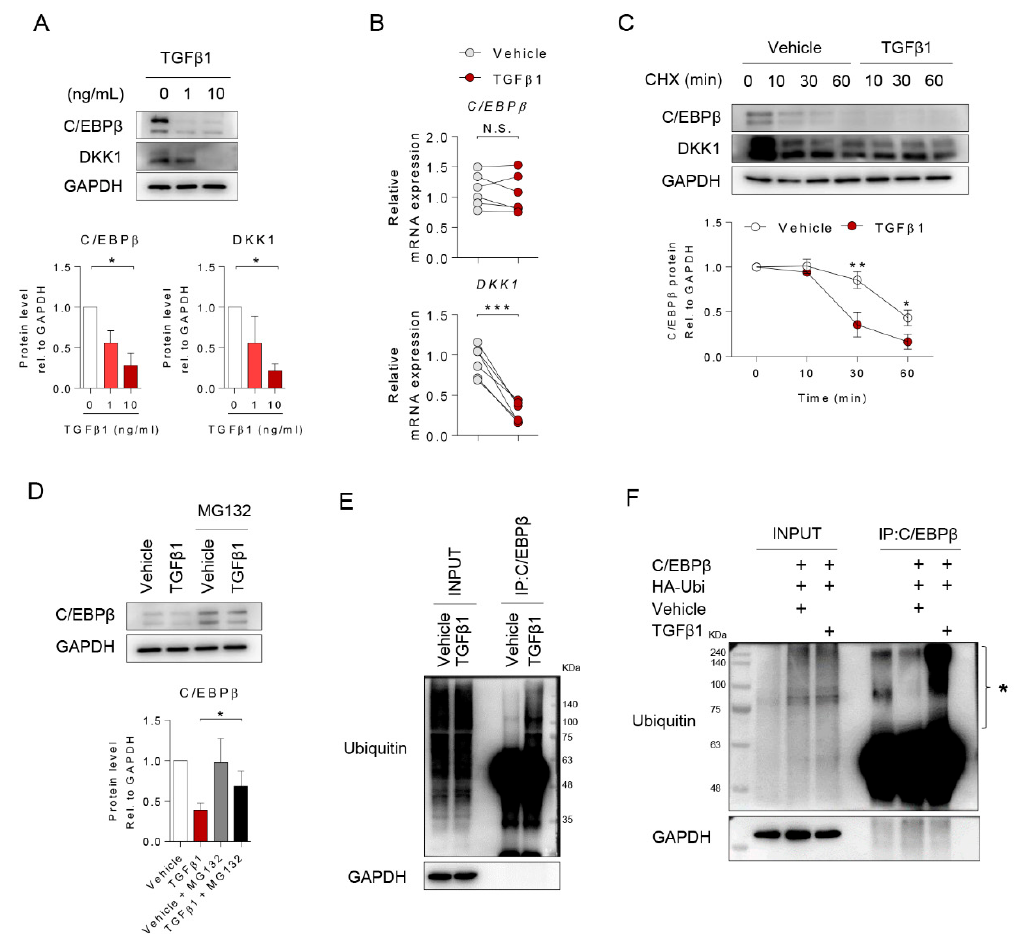
Figure 4. TGF β 1 inhibited DKK1 expressions by ubiquitin-mediated C / EBP β protein degradation. Osteoprogenitors were stimulated with 0, 1, and 10 ng / mL TGF β 1 for 24 h, lysed, and subjected to analysis for ( A ) immunoblotting (upper) and quantification of the immunoblot images (lower, n = 3), and ( B ) qPCR with C / EBP β and DKK1 expressions ( n = 5). ( C ) Osteoprogenitors were pretreated with cycloheximide (CHX), protein synthesis inhibitor, for 30 min, followed by treatment with 10 ng / mL TGF β 1 for the times indicated, and analyzed by immunoblotting (upper) and quantification of the immunoblot images (lower, n = 5). ( D ) Osteoprogenitors were pretreated with MG132, proteasome inhibitor, for 30 min, followed by treatment with 10 ng / mL TGF β 1 for 24 h and analyzed by immunoblotting and quantified with Image J ( n = 3; normalized to GAPDH). ( E ) Osteoprogenitors were stimulated with 10 ng / mL TGF β 1 for 24 h, followed by IP with C / EBP β antibody and analyzed by immunoblotting ( n = 4). ( F ) 293T cells were co-transfected with C / EBP β and HA-Ubi plasmids for 24 h, followed by treatment with 10 ng / mL TGF β 1 for 24 h, IP with C / EBP β antibody, and analyzed by immunoblotting ( n = 3). Asterisk indicated poly-ubiquitin with C / EBP β protein. Values are expressed as the mean ± SD. * p < 0.05; ** p < 0.01; *** p < 0.001; N.S. Not